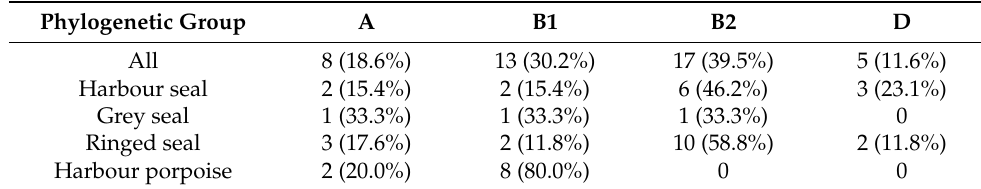
Table 2. Phylogenetic groups. Number and percentage of phylogenetic groups of isolates from the four sampled marine mammal species, as well as for all the